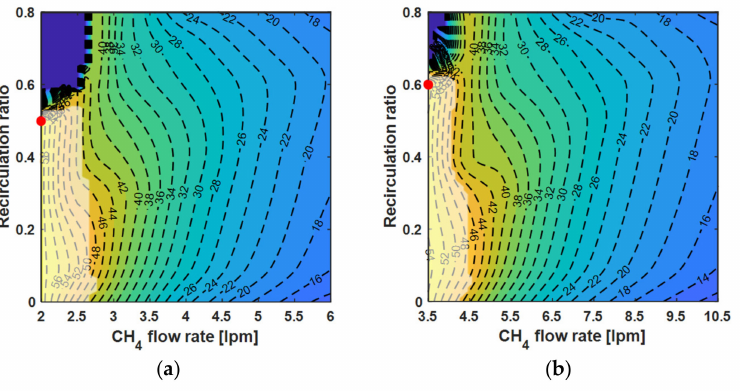
Figure 5. Change of electrical efficiency with various fuel flow rates and recirculation ratios at operating current densities of ( a ) 0.3 A/cm 2 and ( b ) 0.5 A/cm 2 .